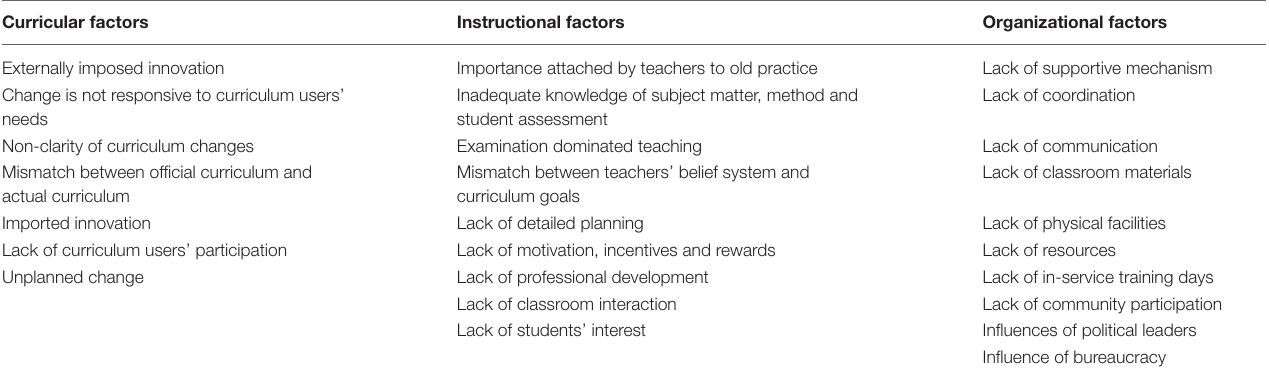
TABLE 1 | Factors affecting educational reform in mathematics education (Memon,